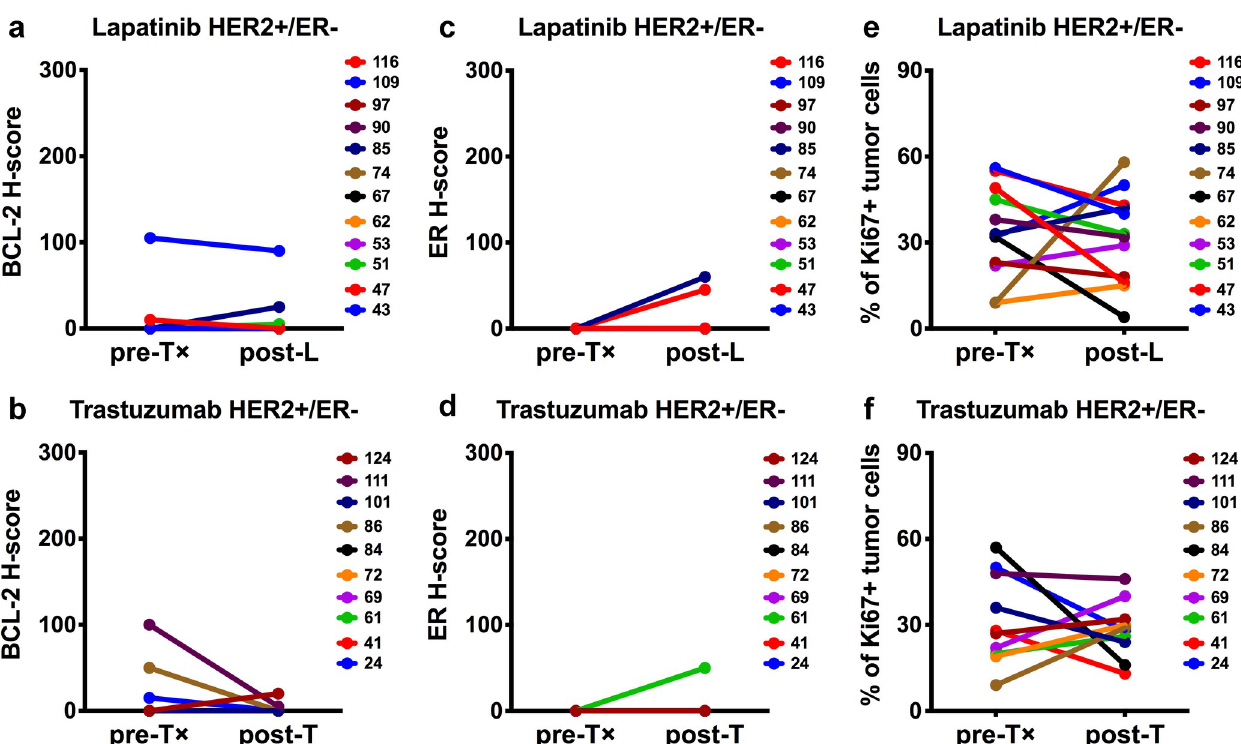
Fig 3. [HER2+/ER-] comparison of BCL-2, ER and Ki67 protein levels pre- and post-lapatinib [L] or post-trastuzumab [T] treatment. Twelve HER2 +/ER- lapatinib-treated and ten HER2+/ER- trastuzumab-treated sample pairs were evaluated for BCL-2 ( a and b ), ER ( c and d ) and Ki67 ( e and f ). BCL-2 and ER were semi-quantitated via H-score assessment. Ki67 values represent the estimated percentage of Ki67+ tumor cells. Each numerical identifier represents a clinical sample pair. Each plot compares baseline (pre-treatment) and run-in (post-treatment) paired samples. Statistical comparisons utilized Wilcoxon matched-pairs signed rank two-tailed test (p-values > 0.05). p-values = [ a ] > 0.9999; [ b ] 0.3750; [ c ] 0.5000; [ d ] > 0.9999; [ e ] 0.6353; [ f ] 0.7695.